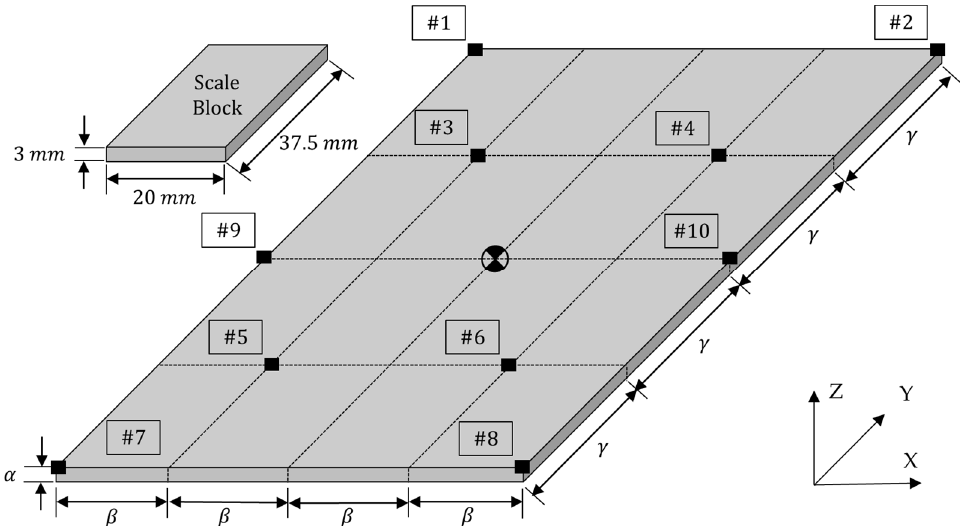
Figure 5. Sensor attachment locations on the UCBC specimen: α : 3 mm, β : 20 mm, γ : 37.5 mm.